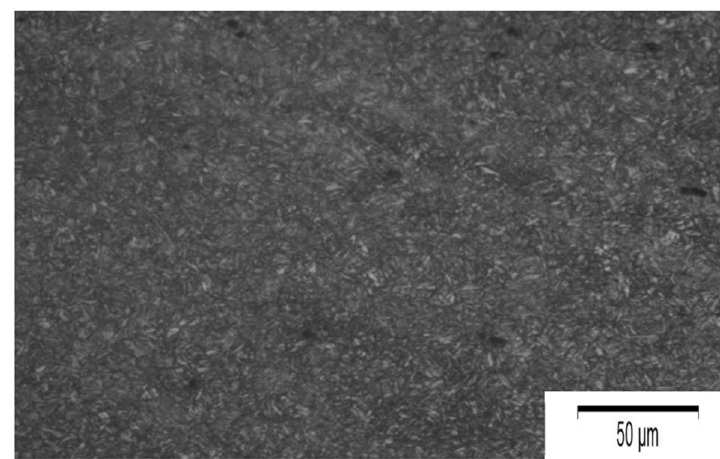
Fig. 19 The microstructure of the base metal (Armox 500T) armor